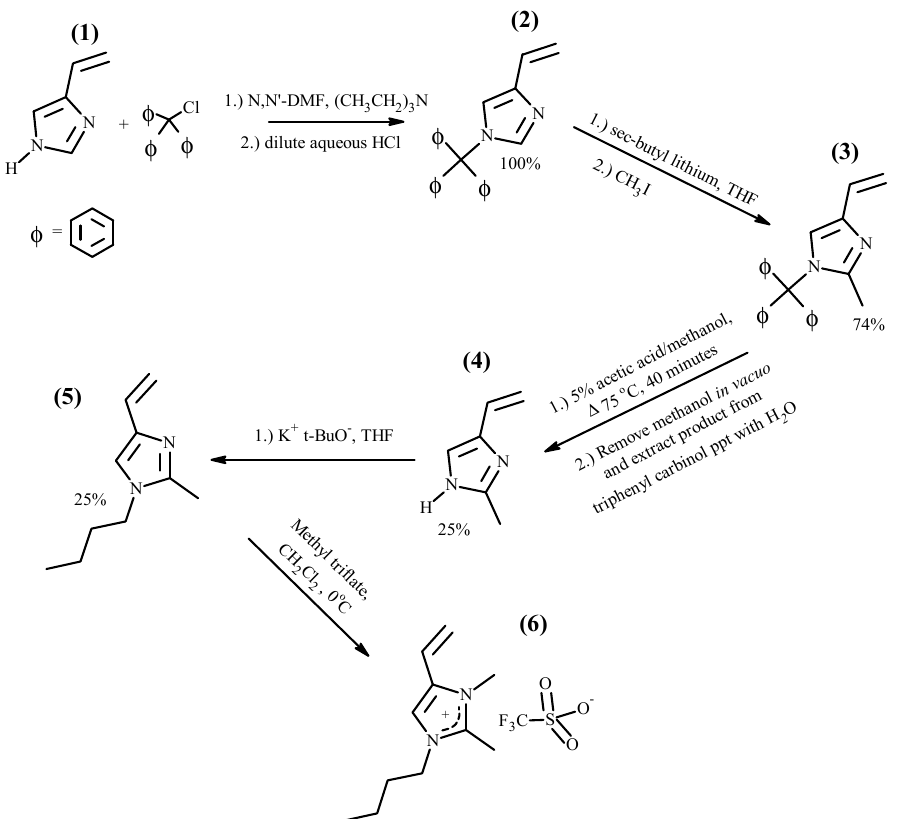
verted to (6) . The successful synthesis of (6) , 1-butyl-2,3-dimethyl-4-vinylimidazolium tri-